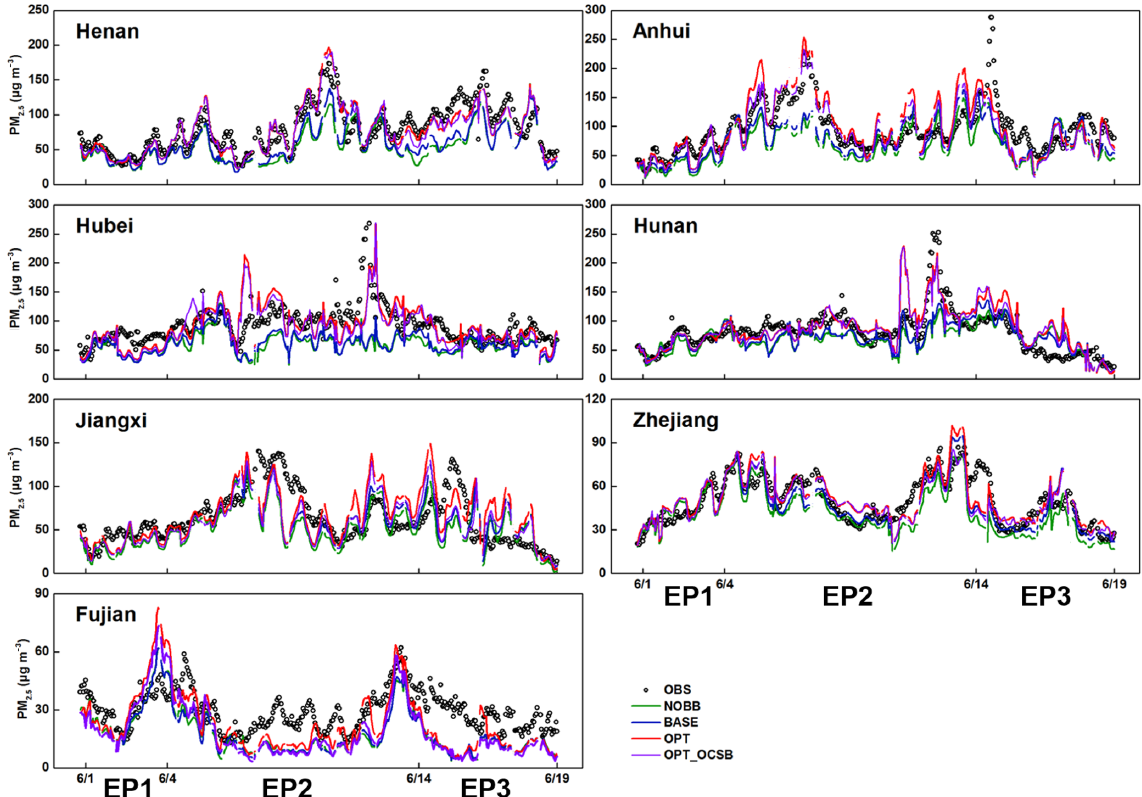
Figure 6. Provincial average temporal variations in ground observed and simulated hourly PM 2 . 5 concentrations in Henan, Anhui, Hubei, Hunan, Jiangxi, Zhejiang, and Fujian. The averaged concentrations for each province were calculated with values at the monitoring stations from both observations and different model simulations (OBS: observations; NOBB: the simulations with only anthropogenic and biogenic emissions; BASE: the simulations with not only anthropogenic and biogenic emissions but also original OBB emissions in FINNv1.5; OPT: the simulations with not only anthropogenic and biogenic emissions but also constrained OBB emissions; OPT_OCSB: the simulations with not only anthropogenic and biogenic emissions but also constrained OCSB